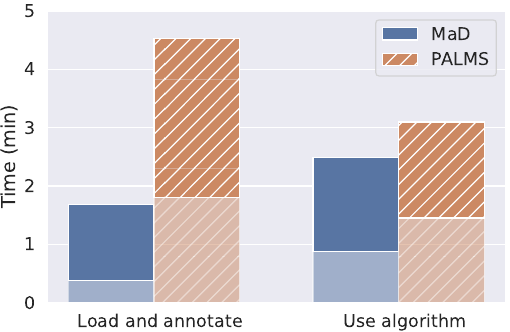
Figure 4. Task completion time for clinicians. Divided into the GUI being in the background (lower opacity) or foreground (higher opacity). Time in the background and foreground are medians over five study participants. For one subject, data recording failed for the task Load and annotate ; however, according to the manually stopped overall time, this person’s data would not change the